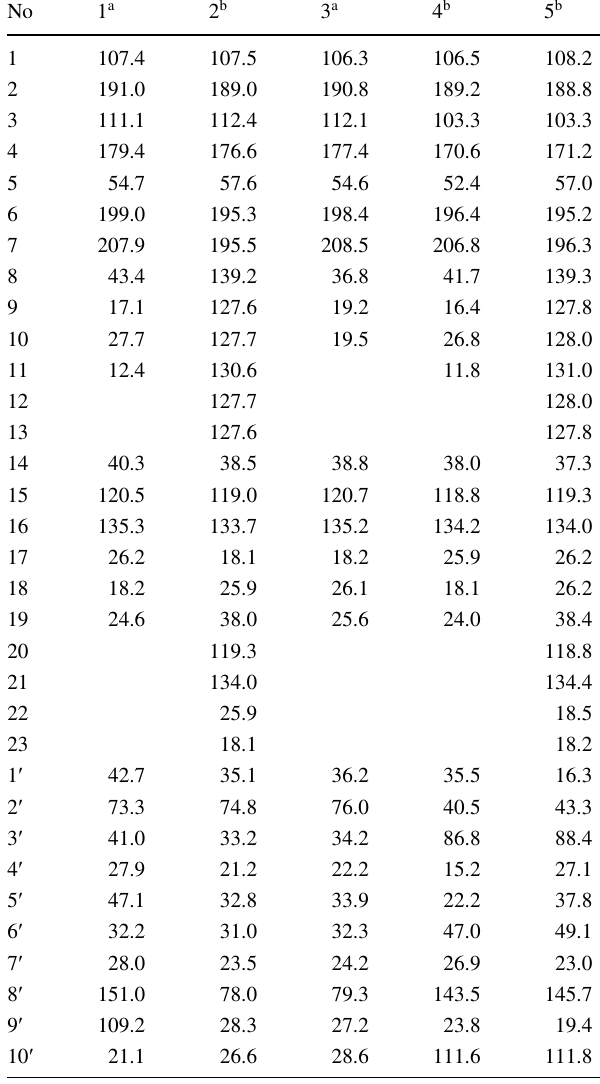
Table 1 The 13 C (150 MHz) NMR data of compounds 1 – 5 ( δ in